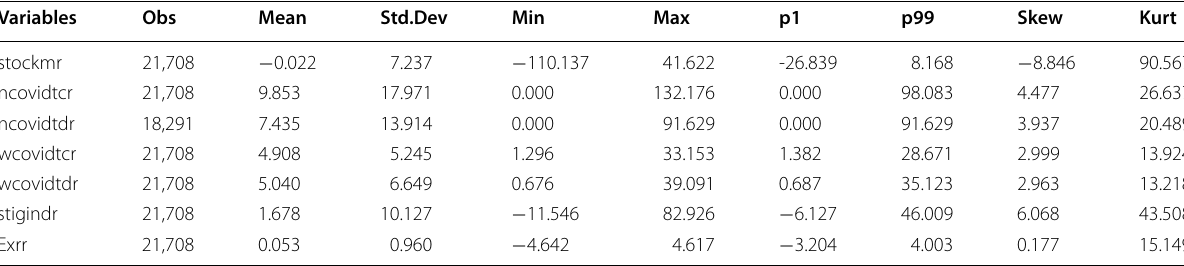
stockmr, ncovidtcr, ncovidtdr, wcovidtcr, wcovidtdr, stigindr and exrr are stock market returns of firms, growth rate of number of the COVID-19 confirmed cases in Nigeria, growth rate of number of COVID-19 confirmed deaths in Nigeria, growth rate of number of the COVID-19 confirmed cases in the World, growth rate of number of COVID-19 confirmed deaths in the World. Growth rate of stringency index (proxy for lockdown) and growth rate of exchange rate, respectively